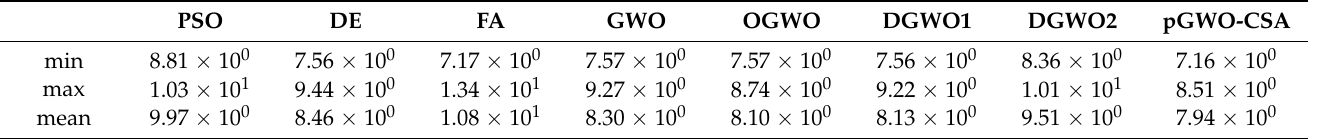
Table 9. Experimental